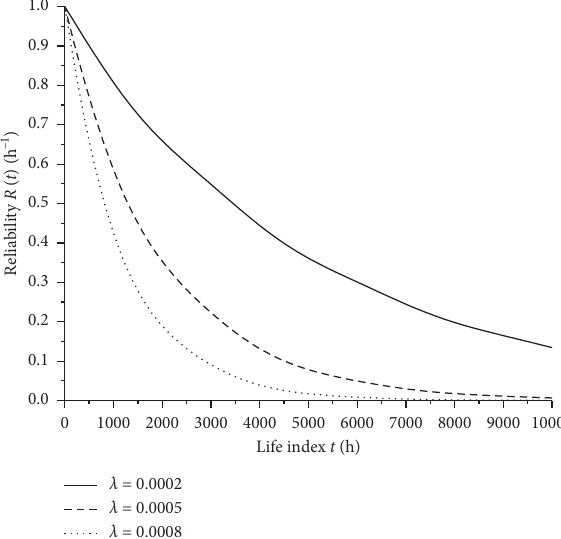
Figure 11: Effects of attenuation coefficient on reliability.